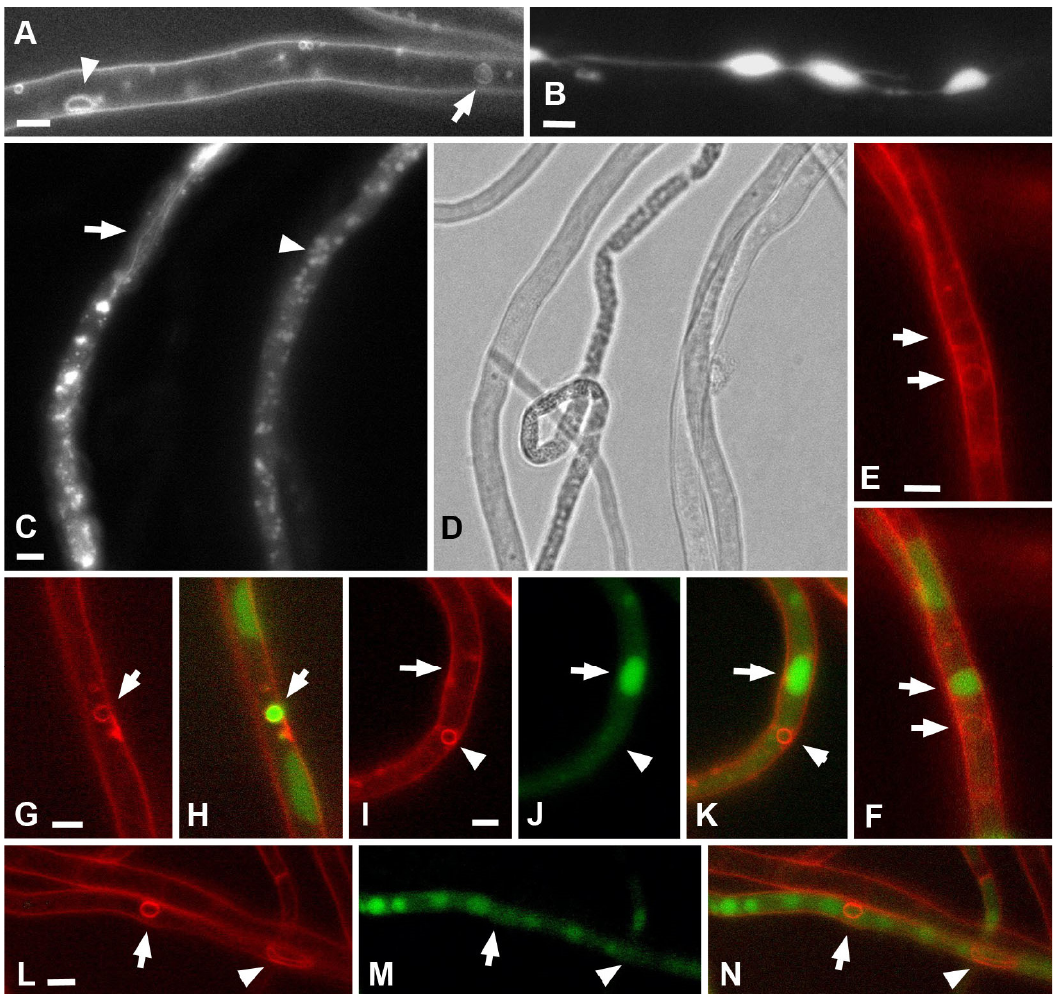
Figure 8. Vacuolar system and colocalization of PM macroinvaginations and vacuoles in S. hirsutum . ( A )—AM4-64 labeling, arrowhead—large vesicle (or thick tube), arrow—VLC (vacuole-lysosome candidate). VLC differs from PM macroinvaginations by its often large size and weaker tonoplast signal. ( B )—CFDA labeling, large oval vacuoles connected by tubular vacuoles. ( C , D )—bright field and CFDA fluorescence images of small round vacuoles (arrowhead) and tubular vacuoles (arrow). ( E , F )—labeling with AM4-64 ( E ); and co-labeling with AM4-64 and CFDA ( F ). Arrows indicate possible VLCs. It can be seen that only one of the two VLCs carries both labels. ( G , H )—the only one of 119 large vesicles analyzed that carries both AM4-64 and CFDA labels (arrow). ( I – N )—demonstration of the most common variant, when the vacuolar label and AM4-64 labeled large vesicles and thick tubes do not match. ( J – K )—the arrow indicates a large central vacuole, and the arrowhead indicates a large vesicle. ( L – N )—the arrow is directed to a large vesicle, and the arrowhead—to a thick tube. Scale bars are 5 µm.